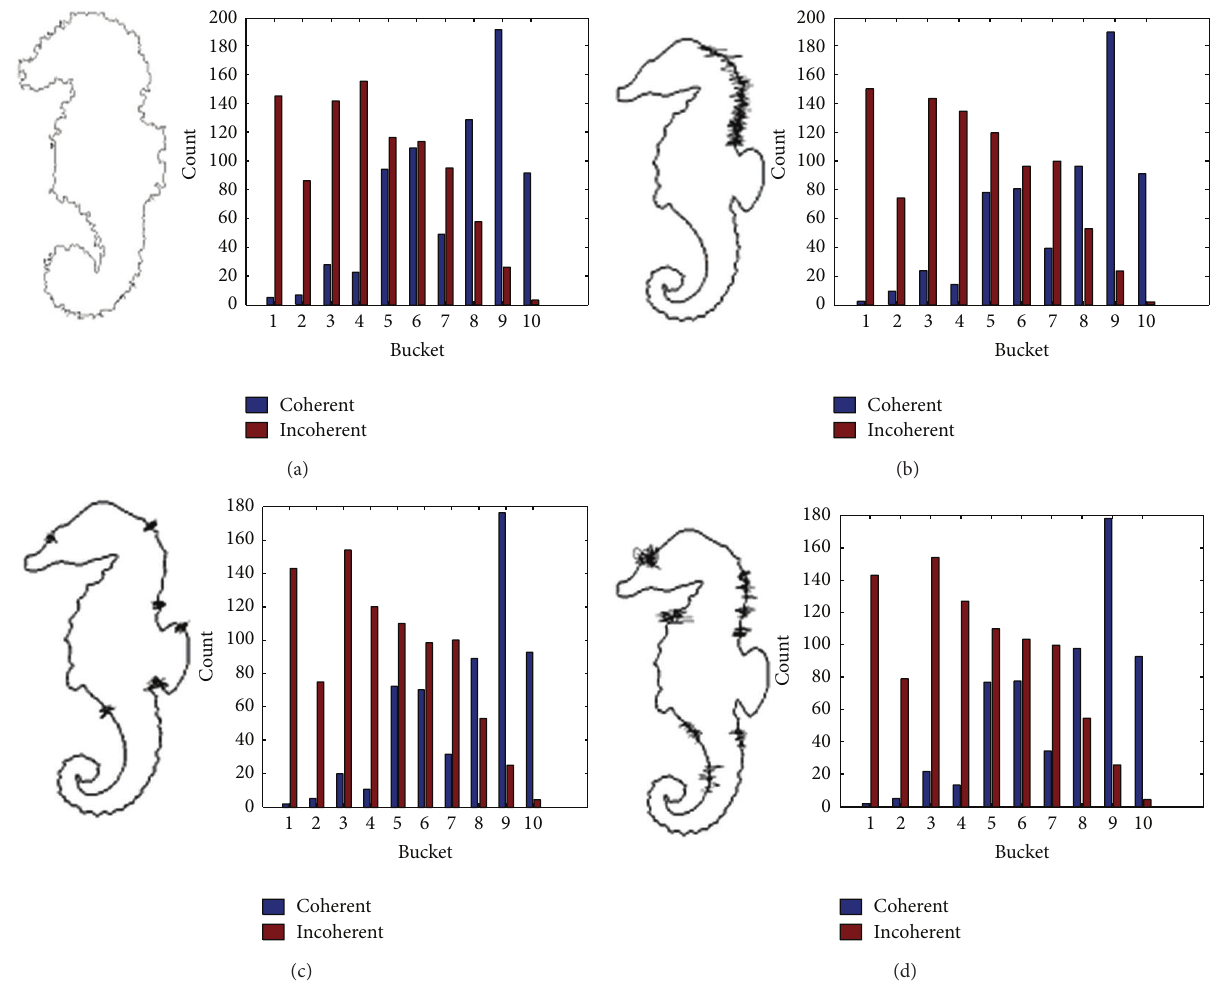
Figure 10: The MDCV histogram of Hippocampus images polluted by different degree noise. (a) Image added noise 1; (b) image added noise 2; (c) image added noise 3; (d) image added noise 4.